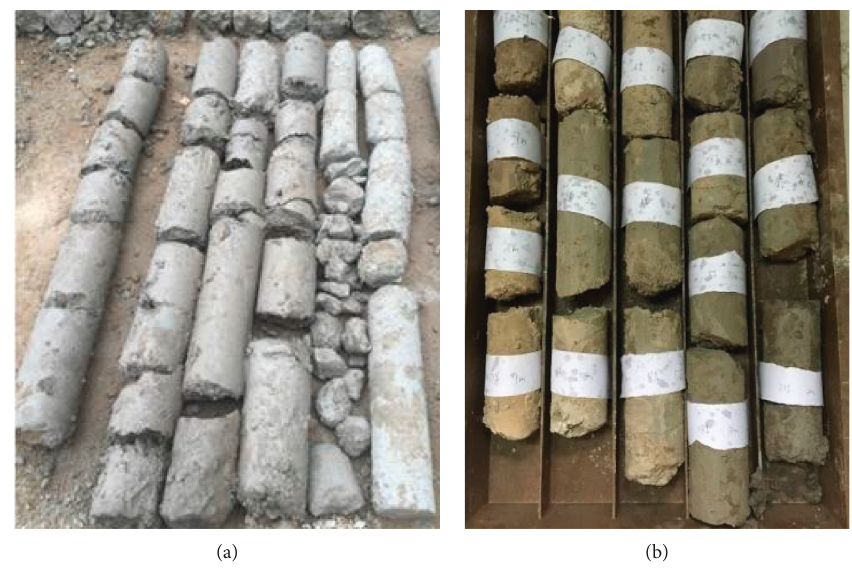
Figure 1: Core-drilling sampling of TRD trial walls: (a) SC4; (b) SC5.